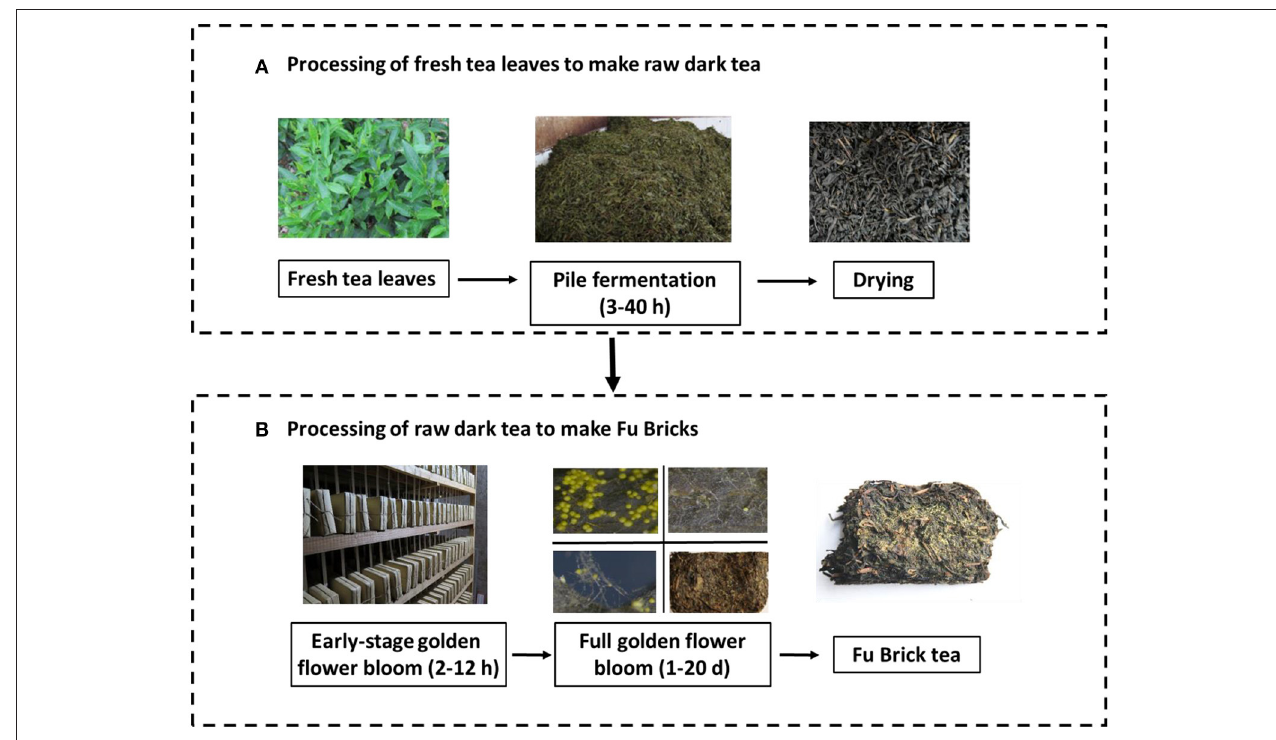
FIGURE 1 | The manufacturing stages of Fu Brick tea. (A) The processing of fresh tea leaves to make raw dark tea. (B) The processing of raw dark tea to make Fu Bricks.